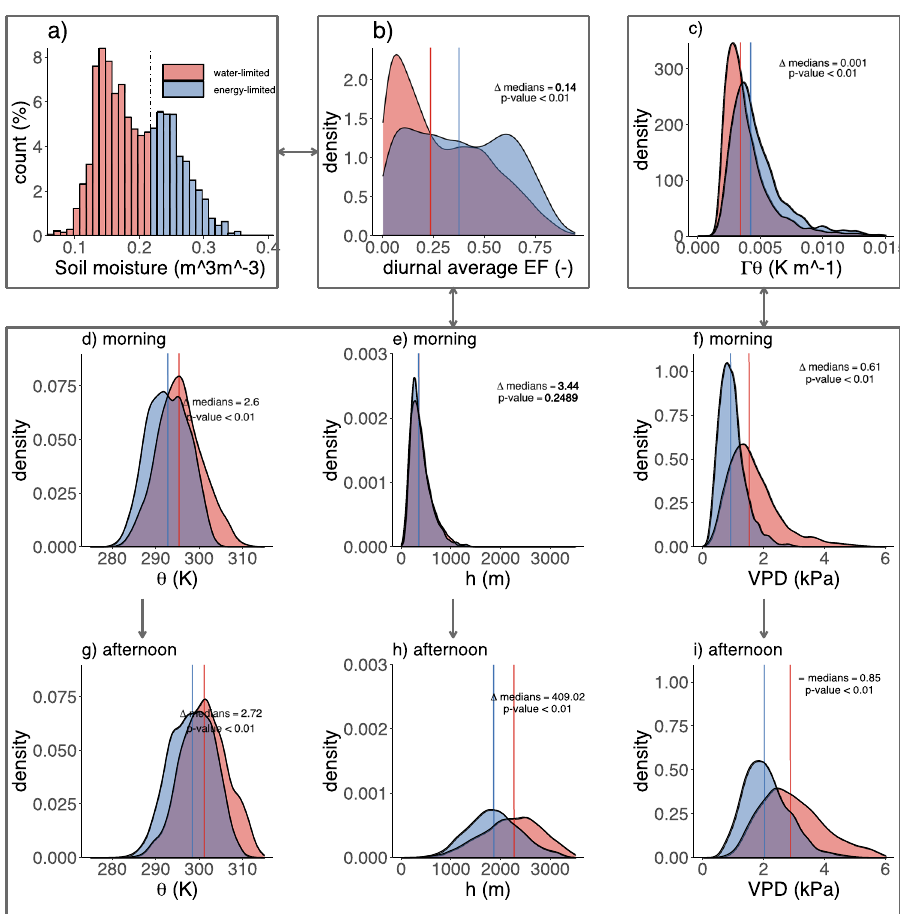
Fig. 4 Global soil moisture in fl uence on diurnal ABL evolution. a Surface soil moisture for available sounding days. When soil moisture is below critical soil moisture (dot-dashed vertical line in Fig. 3c and here), we distinguish water-limited conditions (red), and energy-limited conditions otherwise (blue). Evaporative fraction ( b ) and potential temperature lapse rate ( c ) from CLASS4GL averaged between 08:00 and 14:00 local solar time. Potential temperature ( d , g ), ABL height ( e , h ), and the vapor pressure de fi cit ( f , i ) from CLASS4GL at 08:00 and 14:00. Vertical blue and red lines denote the medians from the respective distributions. Annotations show the difference between the medians and the p values of the Kolmogorov – Smirnov test. Dark grey arrows indicate assumed causal relations between